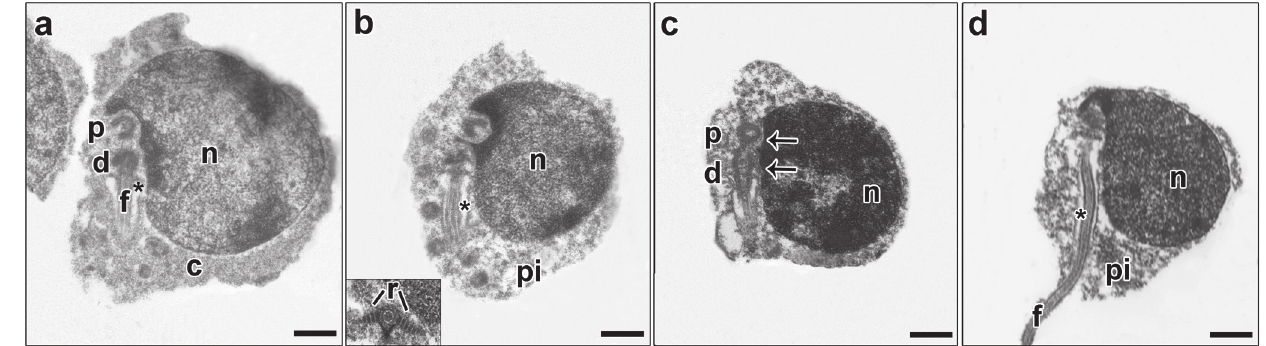
Fig. 1. Spermiogenesis process representative for Lebiasina and Piabucina . Figure subunits are longitudinal sections of spermatids corresponding to ( a ) Lebiasina aff. uruyensis 1, ( b ) L. aff. uruyensis 1, ( c ) Piabucina boruca , and ( d ) P. elongata. The flagellum is initially lateral to the nucleus. A slightly movement of the nucleus towards the flagellar axis is present. Consequently the centriolar complex and the nuclear fossa is superolateral. During spermiogenesis, the formation of two striated rootlets occurs on opposite sides of the distal centriole. c: cytoplasm, d: distal centriole, f: flagellum, n: nucleus, p: proximal centriole, pi: midpiece, r: striated rootlet, asterisk: cytoplasmic canal, arrow: nuclear fossa. Bar = 0.5 μ m.